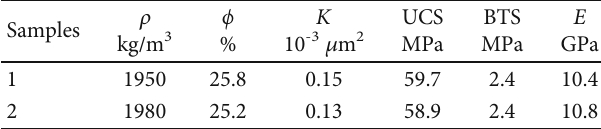
Table 1: Material properties of the test samples.